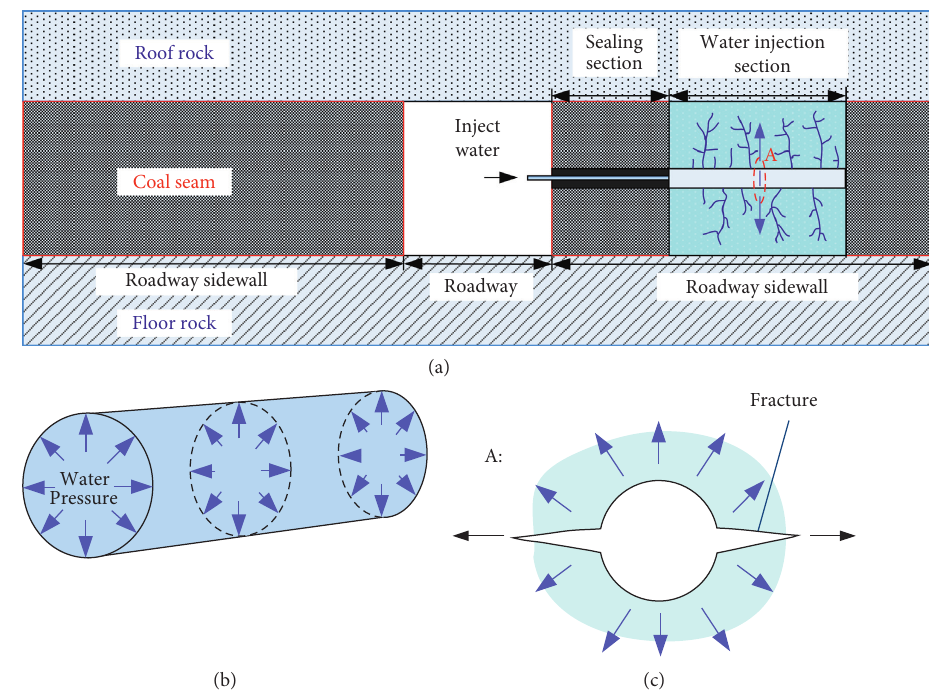
Figure 1: Diagram of hydraulic fracturing: (a) hydraulic fracturing diagram in roadway sidewall, (b) effect of water pressure in water injection section, and (c) diagram of fracture initiation in section A.